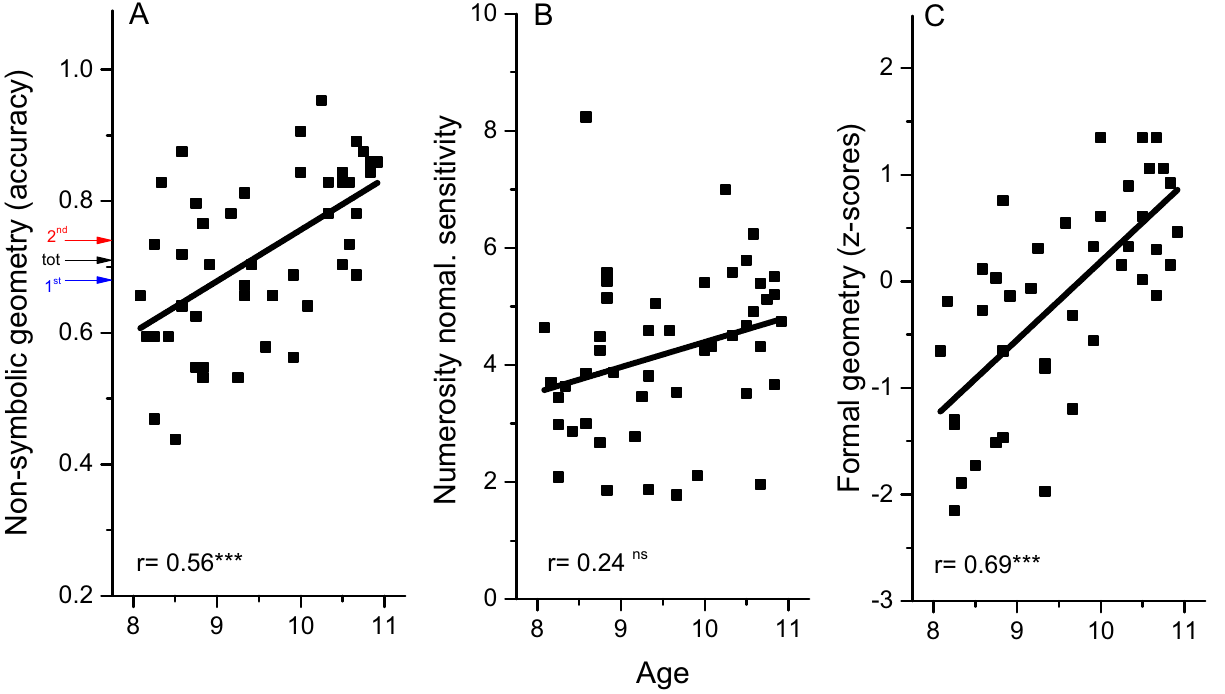
Figure 2. Data from individual participants as a function of age. ( A ) Accuracy in the non-symbolic geometry task. Arrows report average accuracy separately for the aggregate index (black) and for the first (blue) and second runs (red) separately. ( B ) Normalized sensitivity for numerosity. ( C) Overall performance in the formal geometry battery. Lines report best linear fits. ns > 0.05; ***p <